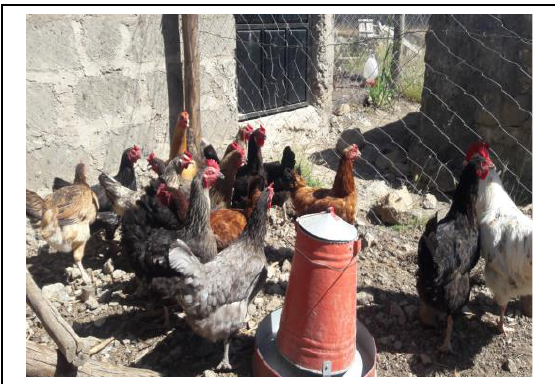
Figure 3: Poultry farming in peri-urban